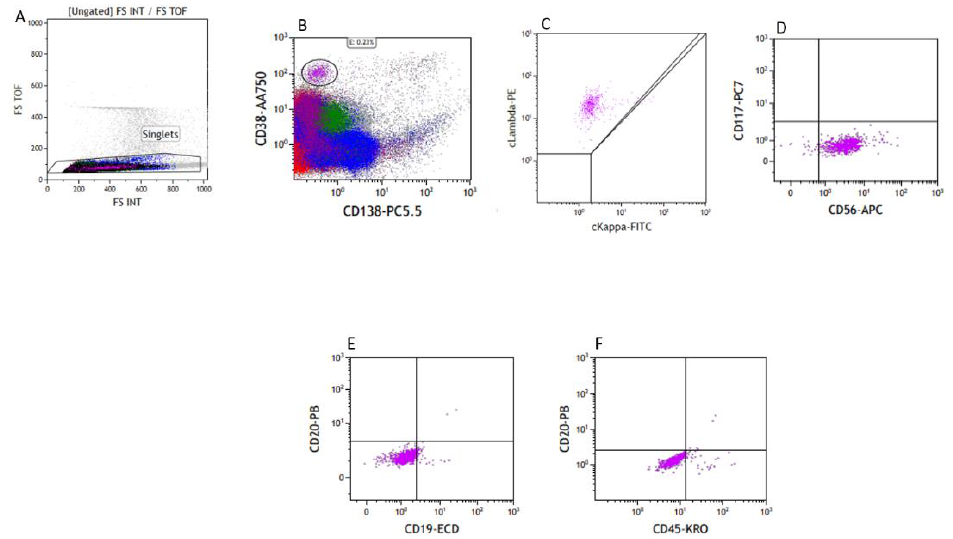
Figure 6. Flow cytometry of the bone marrow, FS-TOF versus FS INT to identify singlets ( A ), with a small population of CD38+/CD138 − cells ( B ), Lambda restricted ( C ), CD117 − /CD56+ ( D ), CD19 − /CD20 − ( E ), and dim CD45+ ( F ).